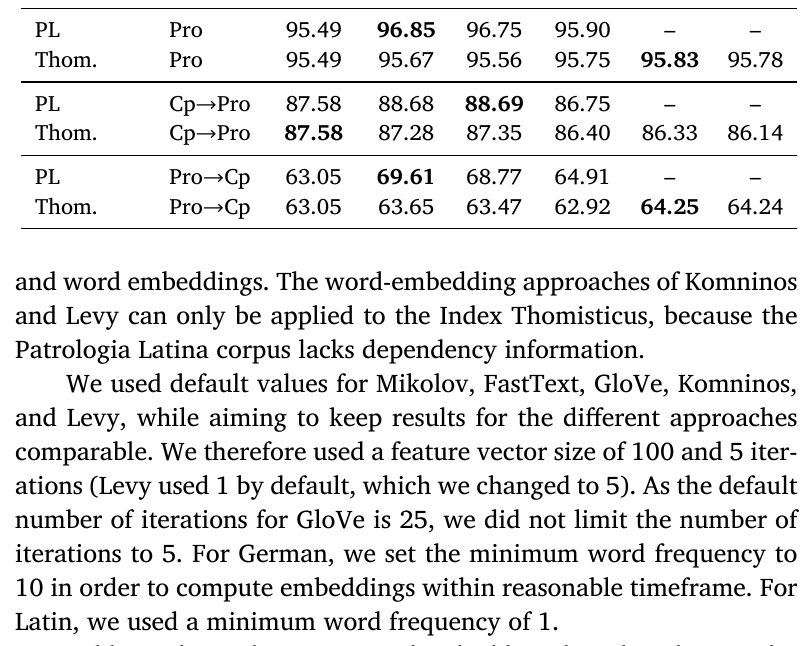
Table 15: POS (CHSTS) accuracy in % using MarMoT, for different types of word embedding, based on two Latin corpora